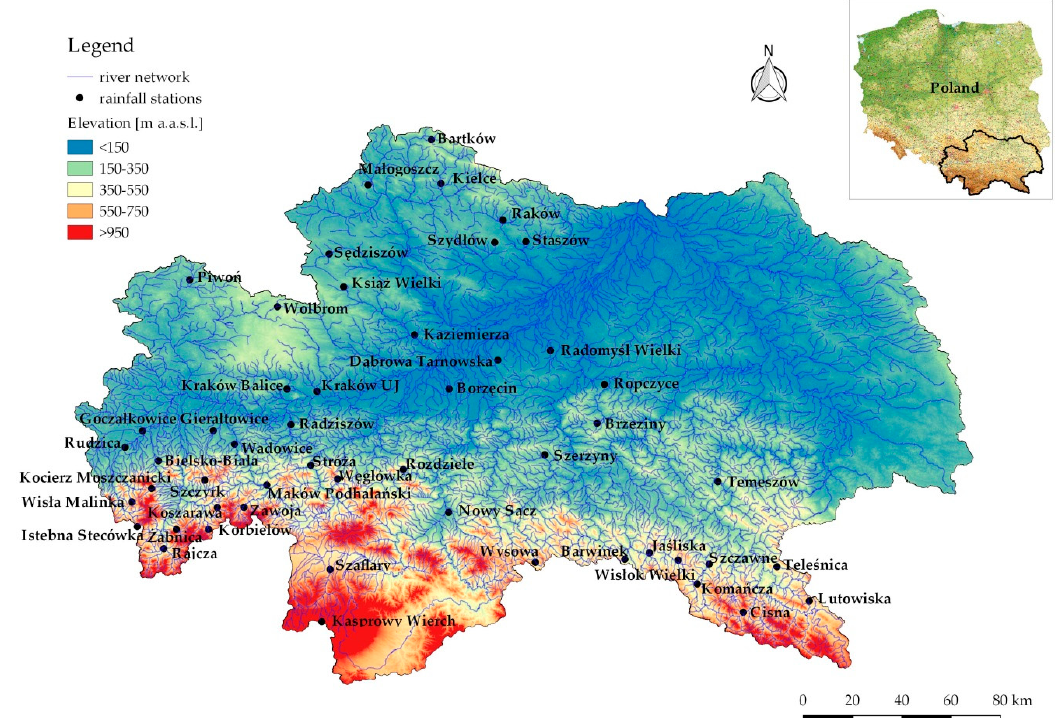
Figure 1. The digital elevation model of Upper Vistula Basin and rainfall stations location (black markers) on the map of Poland.